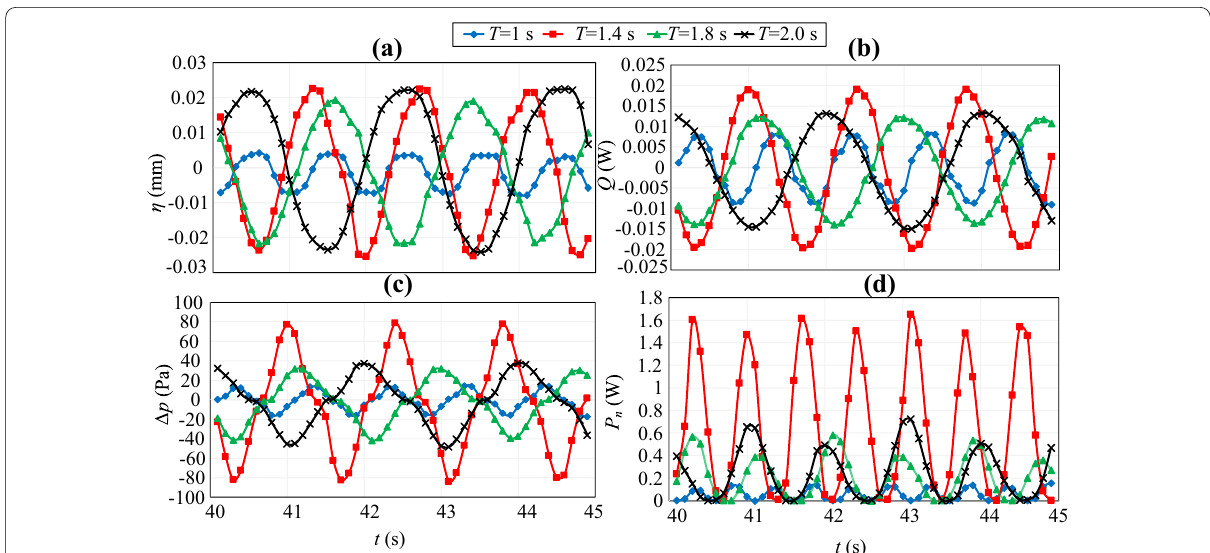
Figure 7 Sample time-series data of: ( a ) the water surface elevation η , ( b ) airflow rate Q , ( c ) the differential air pressure p , and ( d ) and the pneumatic power P n in the first chamber over four different wave periods at a constant wave height H